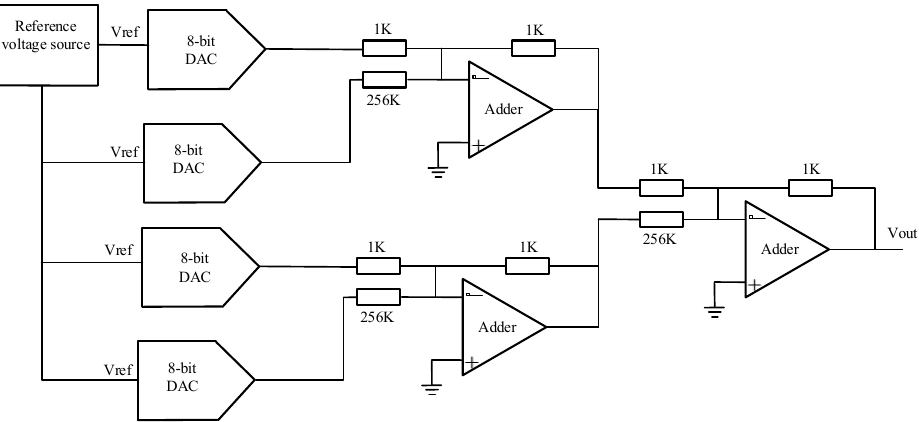
Figure 3. Schematic diagram of output stacking method [14].